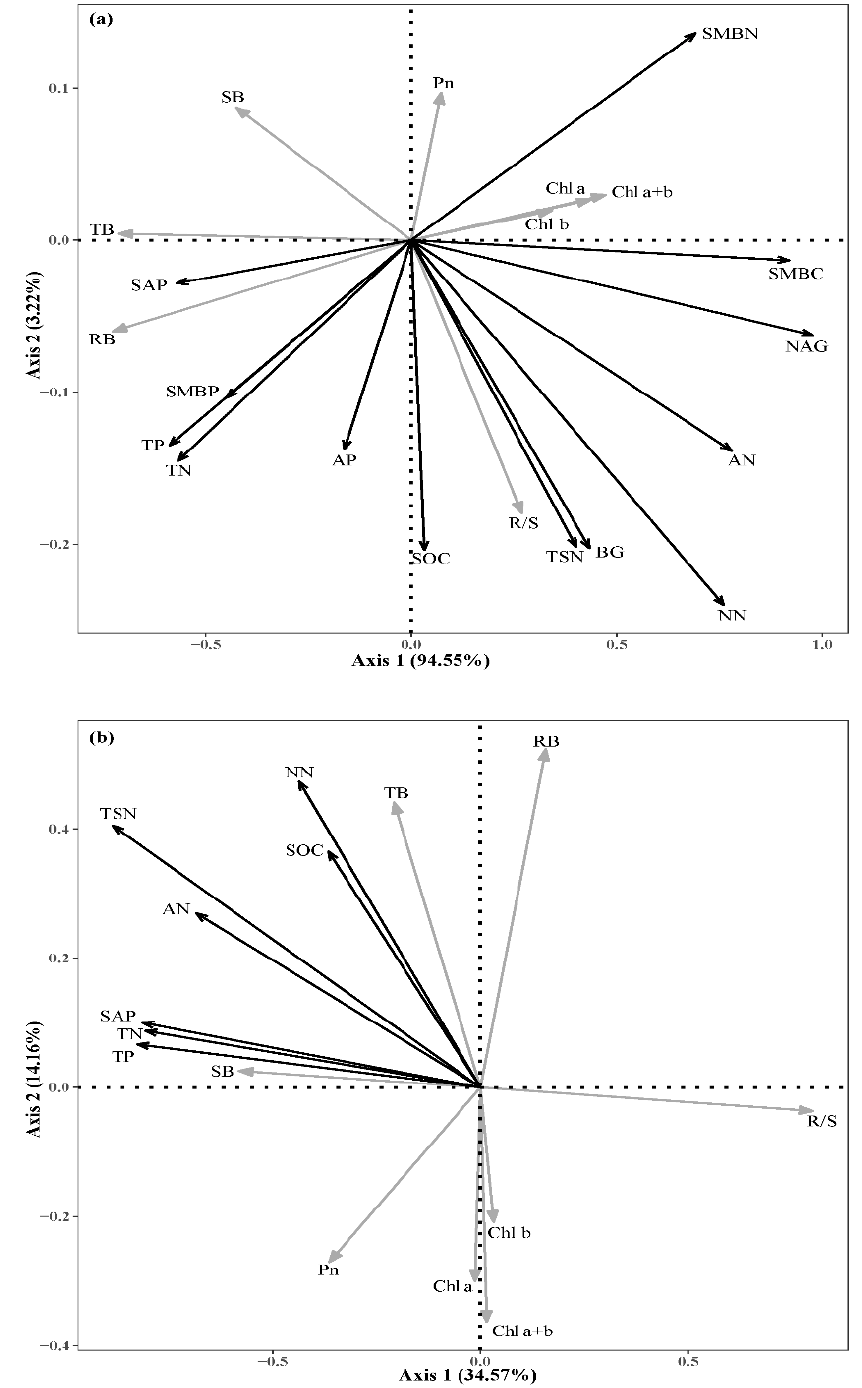
Figure 3. Bidimensional graph of the redundancy analysis, indicating the relationships between plant growth indexes and soil parameters, in the unsterilized soils ( a ) and sterilized soils ( b ). SB, shoot biomass; RB, root biomass; TB, total biomass; R/S, root to shoot biomass; Pn, net photosynthetic rate; Chl a, chlorophyll a; Chl b, chlorophyll b; Chl a + b, chlorophyll a + b; SOC, soil organic carbon; TN, soil total nitrogen; TP, soil total phosphorus; SAP, soil available phosphorus; TSN, soil total soluble nitrogen; NN, soil nitrate nitrogen; AN, soil ammonium nitrogen; BG, β -1,4-glucosidase; NAG, β -1,4-N-acetylglucosaminidase; AP, acid phosphatase; SMBC, soil microbial biomass carbon; SMBN, soil microbial biomass nitrogen; SMBP, soil microbial biomass phosphorus.